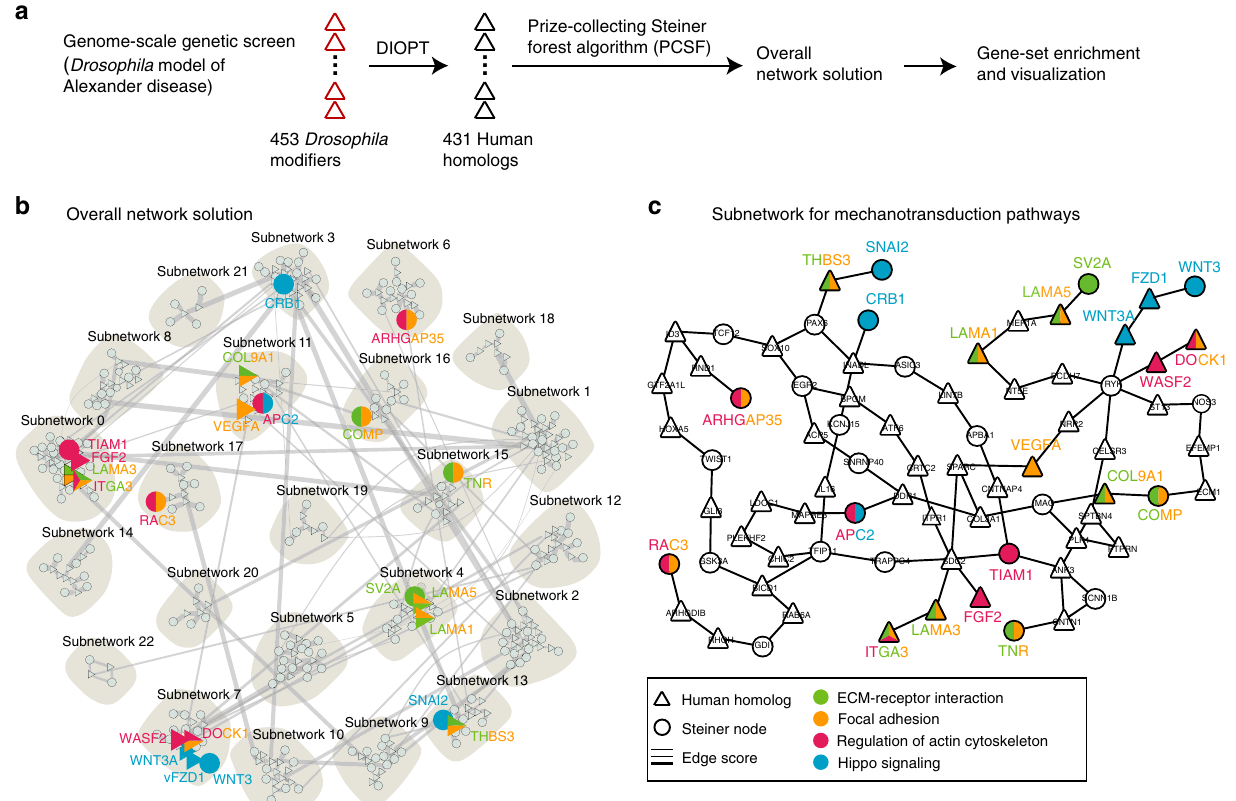
Fig. 1 Genetic screen implicates mechanotransduction pathways. a Schematic representation of the data analysis for the results of a genome-scale genetic screen in the Drosophila model of Alexander disease. DIOPT: DRSC Integrative Ortholog Prediction Tool. b The overall network solution using the prize- collecting Steiner forest algorithm (PCSF) identi fi es pathways (green-, orange-, red-, and blue- fi lled nodes) implicated in mechanotransduction. Human homologs are represented as triangles; whereas, circles indicate Steiner nodes, or proteins that were not identi fi ed as modi fi ers in the fl y screen, but are strongly implicated by the data and the PCSF. Edges indicate physical protein – protein interactions, with thickness being the con fi dence of the interaction based on experimental evidence compiled in iRefIndex13. c A subnetwork highlighting interactions of proteins implicated in mechanotransduction